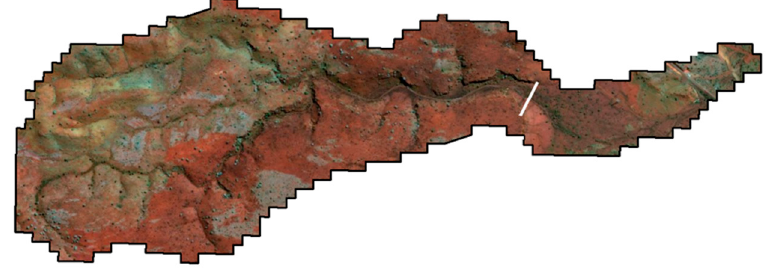
Figure 7. Catchment with a digitized white line showing a cross section (Plot output) for the TUFLOW TUFLOW model.